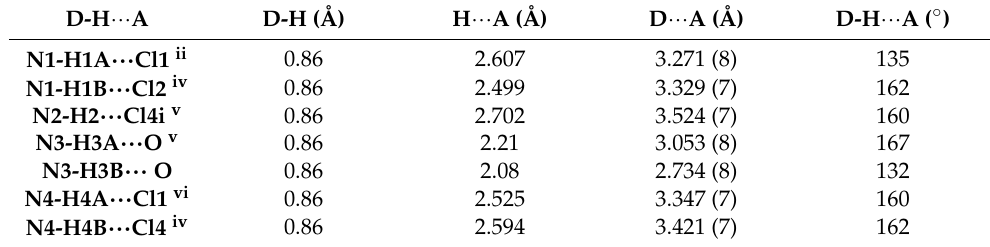
Table 2. Hydrogen-bond geometry for (C 2 H 7 N 4 O) 2 BiCl 5 .